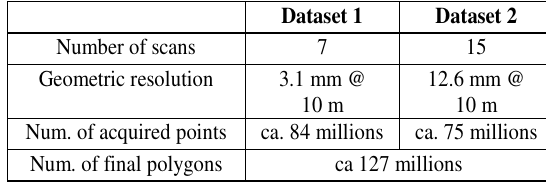
Table 1. Comparison of the two different datasets acquired with